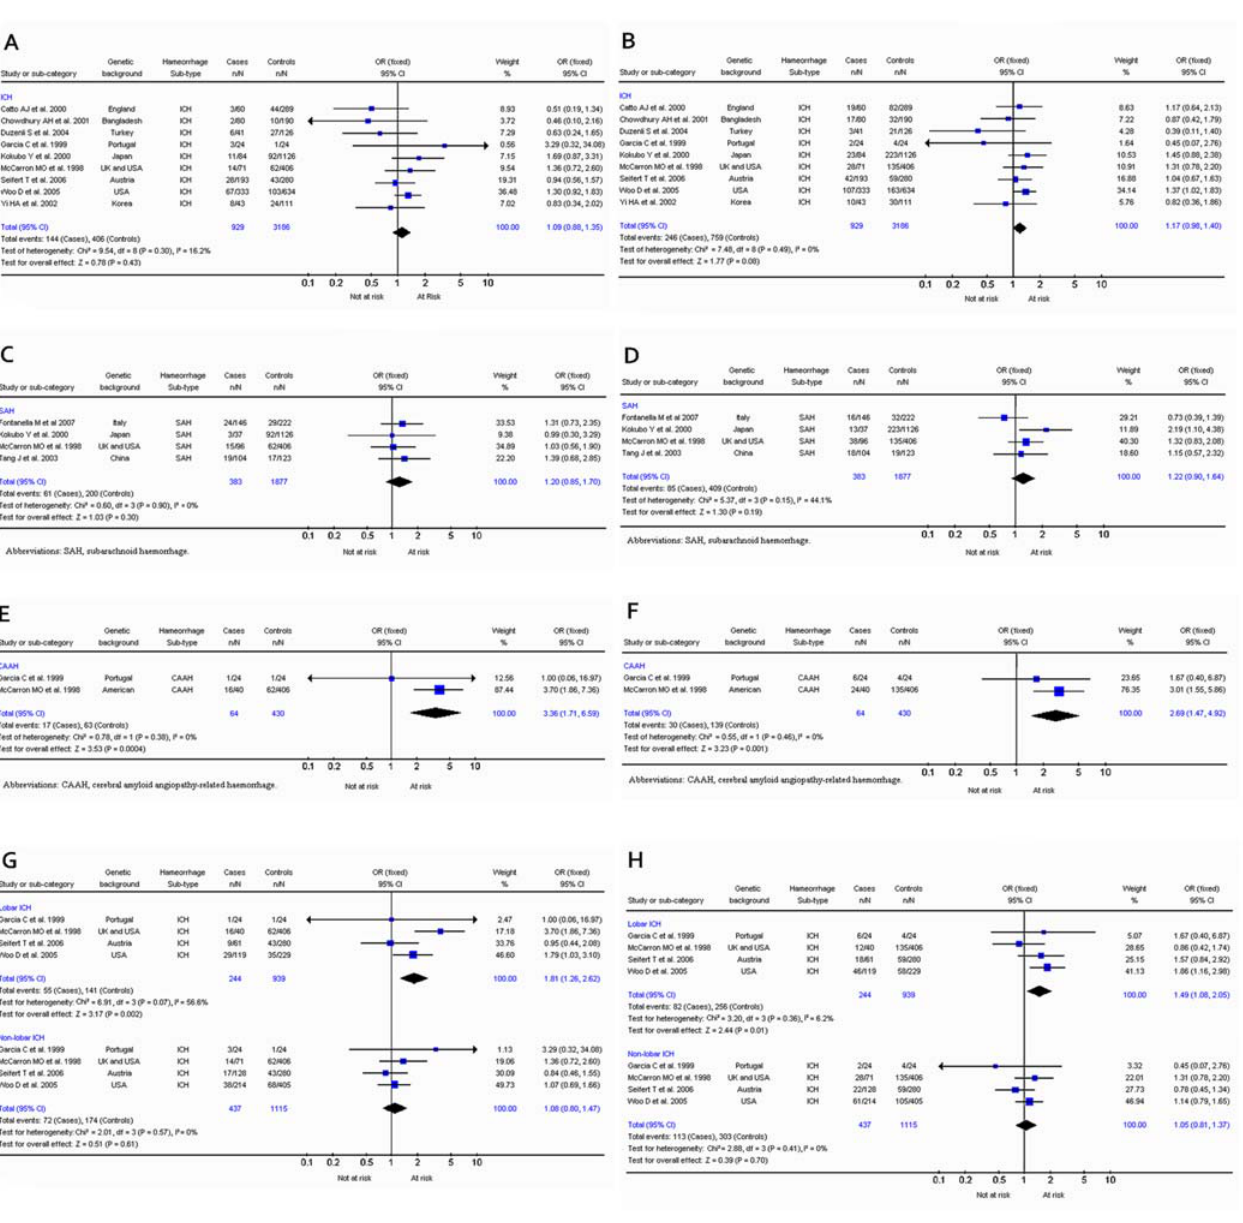
Figure 2. 2a. Results for apolipoprotein E 2 allele and intracerebral haemorrhage comparing carriers of the E 2 allele with those with the E 3 and E 4 alleles. 2b. Results for apolipoprotein E 4 allele and intracerebral haemorrhage comparing carriers of the E 4 allele with those with the E 2 and E 3 alleles. 2c. Results for apolipoprotein E 2 allele and subarachnoid haemorrhage comparing carriers of the E 2 allele with those with the E 3 and E 4 alleles. 2d. Results for apolipoprotein E 4 allele and subarachnoid haemorrhage comparing carriers of the E 4 allele with those with the E 2 and E 3 alleles. 2e. Results for apolipoprotein E 2 allele and cerebral amyloid angiopathy-related haemorrhage comparing carriers of the E 2 allele with those with the E 3 and E 4 alleles. 2f. Results for apolipoprotein E 4 allele and cerebral amyloid angiopathy-related haemorrhage comparing carriers of the E 4 allele with those with the E 2 and E 3 alleles. 2g. Results for apolipoprotein E 2 allele and lobar or non-lobar haemorrhage comparing carriers of the E 2 allele with those with the E 3 and E 4 alleles. 2h. Results for apolipoprotein E 4 allele and lobar or non-lobar haemorrhage comparing carriers of the E 4 allele with those with the E 2 and E 3 alleles.